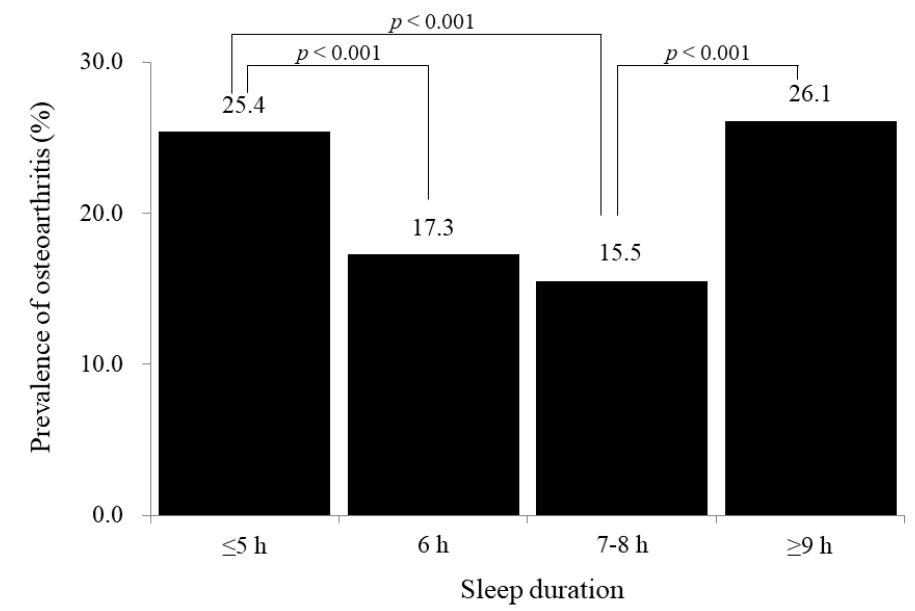
Figure 1. Prevalence of osteoarthritis according to sleep duration ( p -values were calculated by post hoc analysis of weighted chi-square test between-groups).